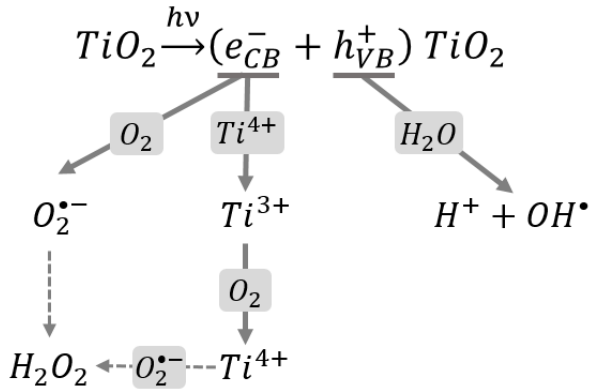
Figure 3. Photo-excitation of TiO 2 and generation of reactive oxygen species (according to